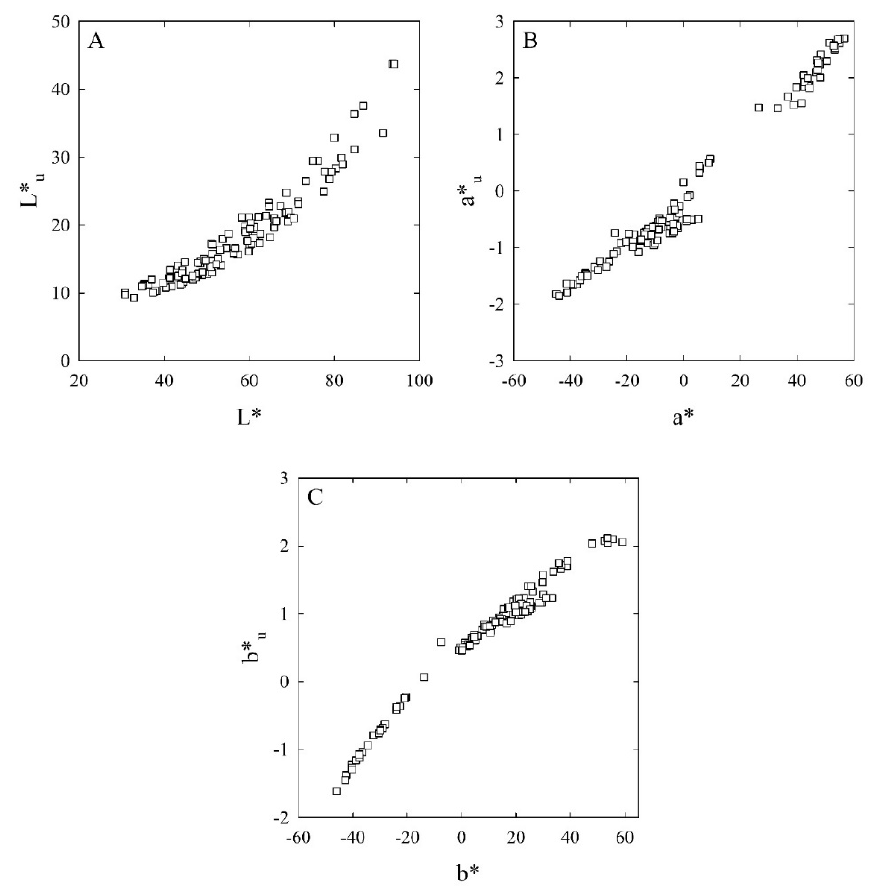
Figure 3. Scatter plots of uncalibrated colourimeter’s L* (L*